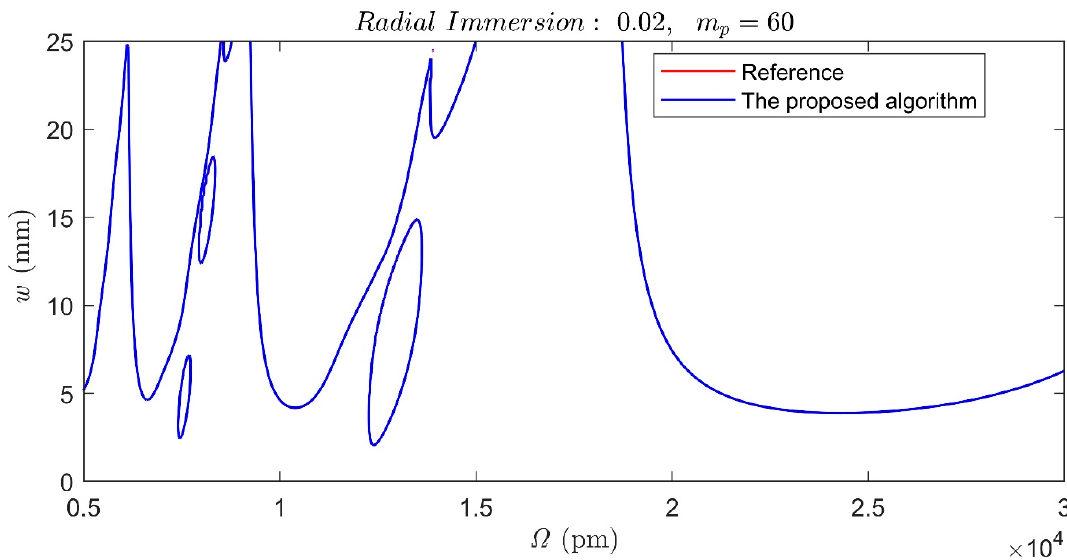
Figure 10. The SLD of the second milling model obtained by the proposed algorithm with radial immersion 0.02, m p =